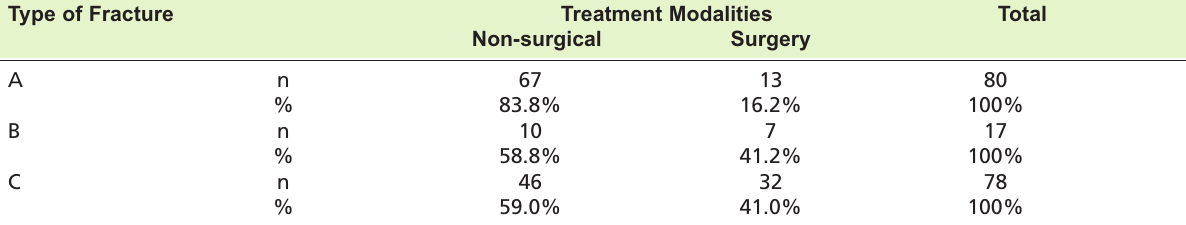
Shows the breakdown of treatment modalities of the patients with respect to the type of fracture Table I: Type of Fracture